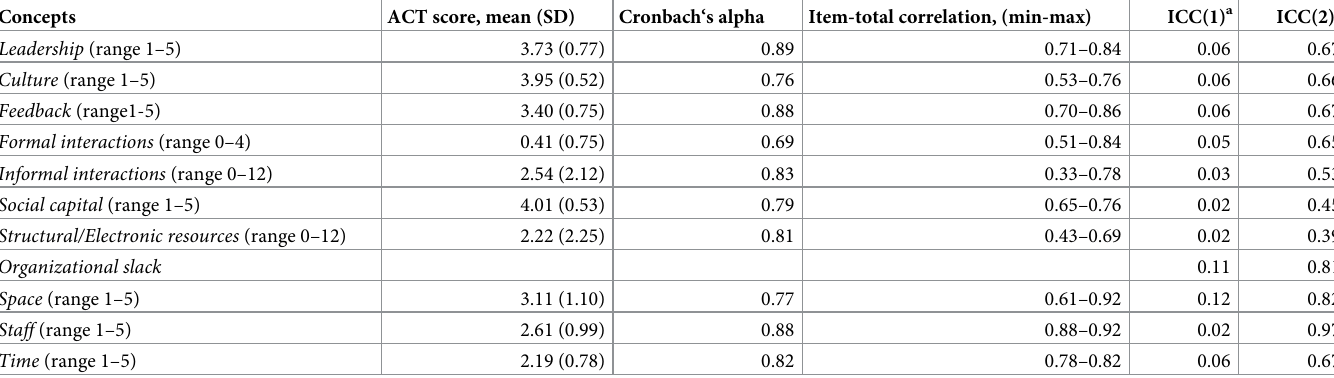
Table 3. Reliability measures for the concepts in the